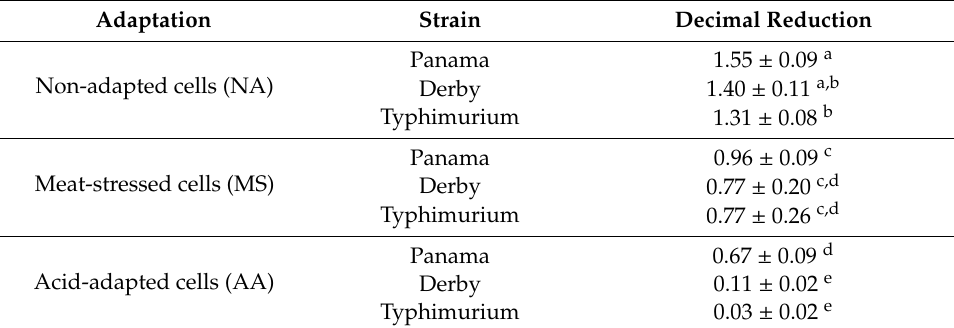
Table 2. Salmonella enterica inactivation after the acid challenge